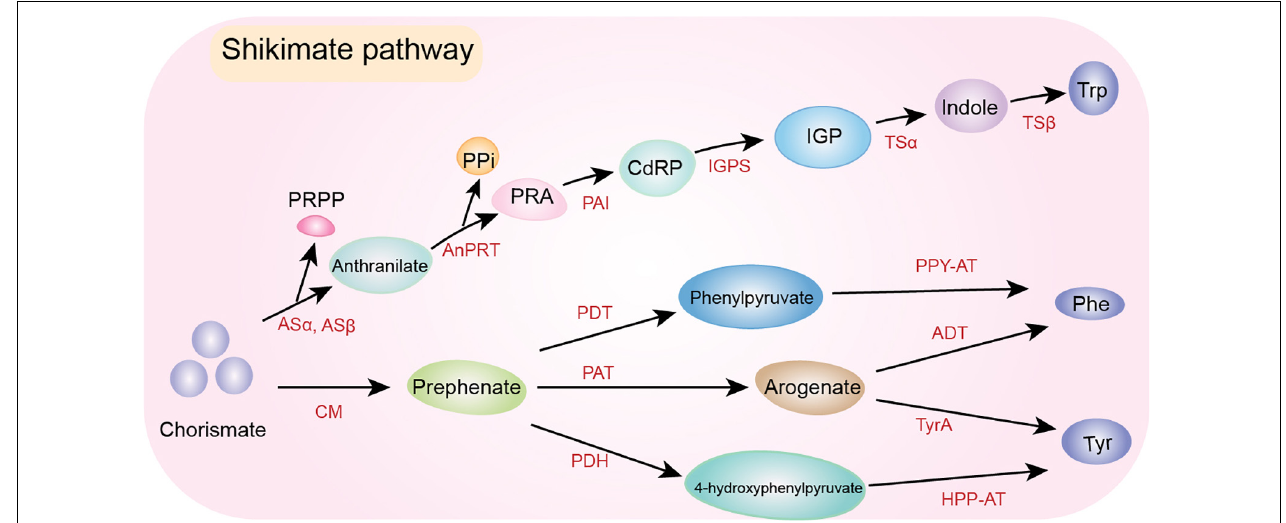
FIGURE 4 | Phe, Tyr, and Trp biosynthetic pathways. Chorismate is the precursor of Phe, Tyr and Trp. Two distinctive pathways starting from the same precursor, Chorismate, where Phe and Tyr share some common intermediates (i.e., prephenate and arogenate) and Trp is produced from a separated branched-chain. ADT, arogenate dehydratase; AnPRT, anthranilate phosphoribosylanthranilate transferase; AS α ; AS β , anthranilate synthase; CdRP, L -(O-carboxyphenylamino)-l-deoxyribulose-5-phosphate; CM, chorismate mutase; HPP-AT, 4-hydroxyphenylpyruvate aminotransferase; IGP, indole-3-glycerol phosphate; IGPS, indole-3-glycerol phosphate synthase; PAI, phosphoribosylanthranilate isomerase; PAT, prephenate aminotransferase; PDH, prephenate dehydrogenase; PDT, prephenate dehydratase; Phe, phenylalanine; PPi, inorganic pyrophosphate; PPY-AT, phenylpyruvate aminotransferase; PRA, phosphoribosylanthranilate; PRPP, phosphoribosyl pyrophosphate; Trp, tryptophan; TS α , tryptophan synthase alpha subunit; TS β , tryptophan synthase beta subunit; Tyr, tyrosine; TyrA, arogenate